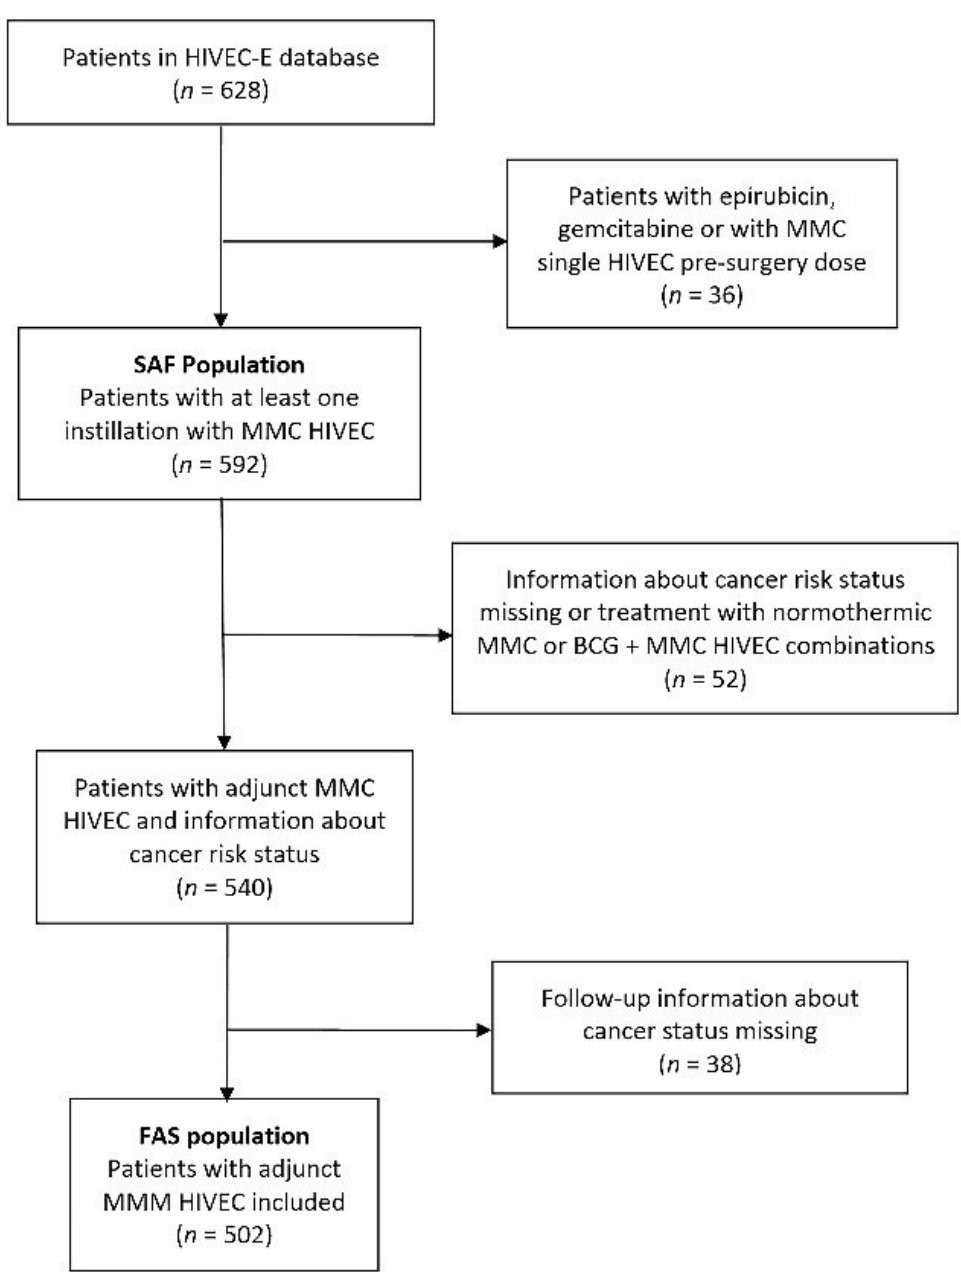
Figure 1. Flowchart of patients included in the